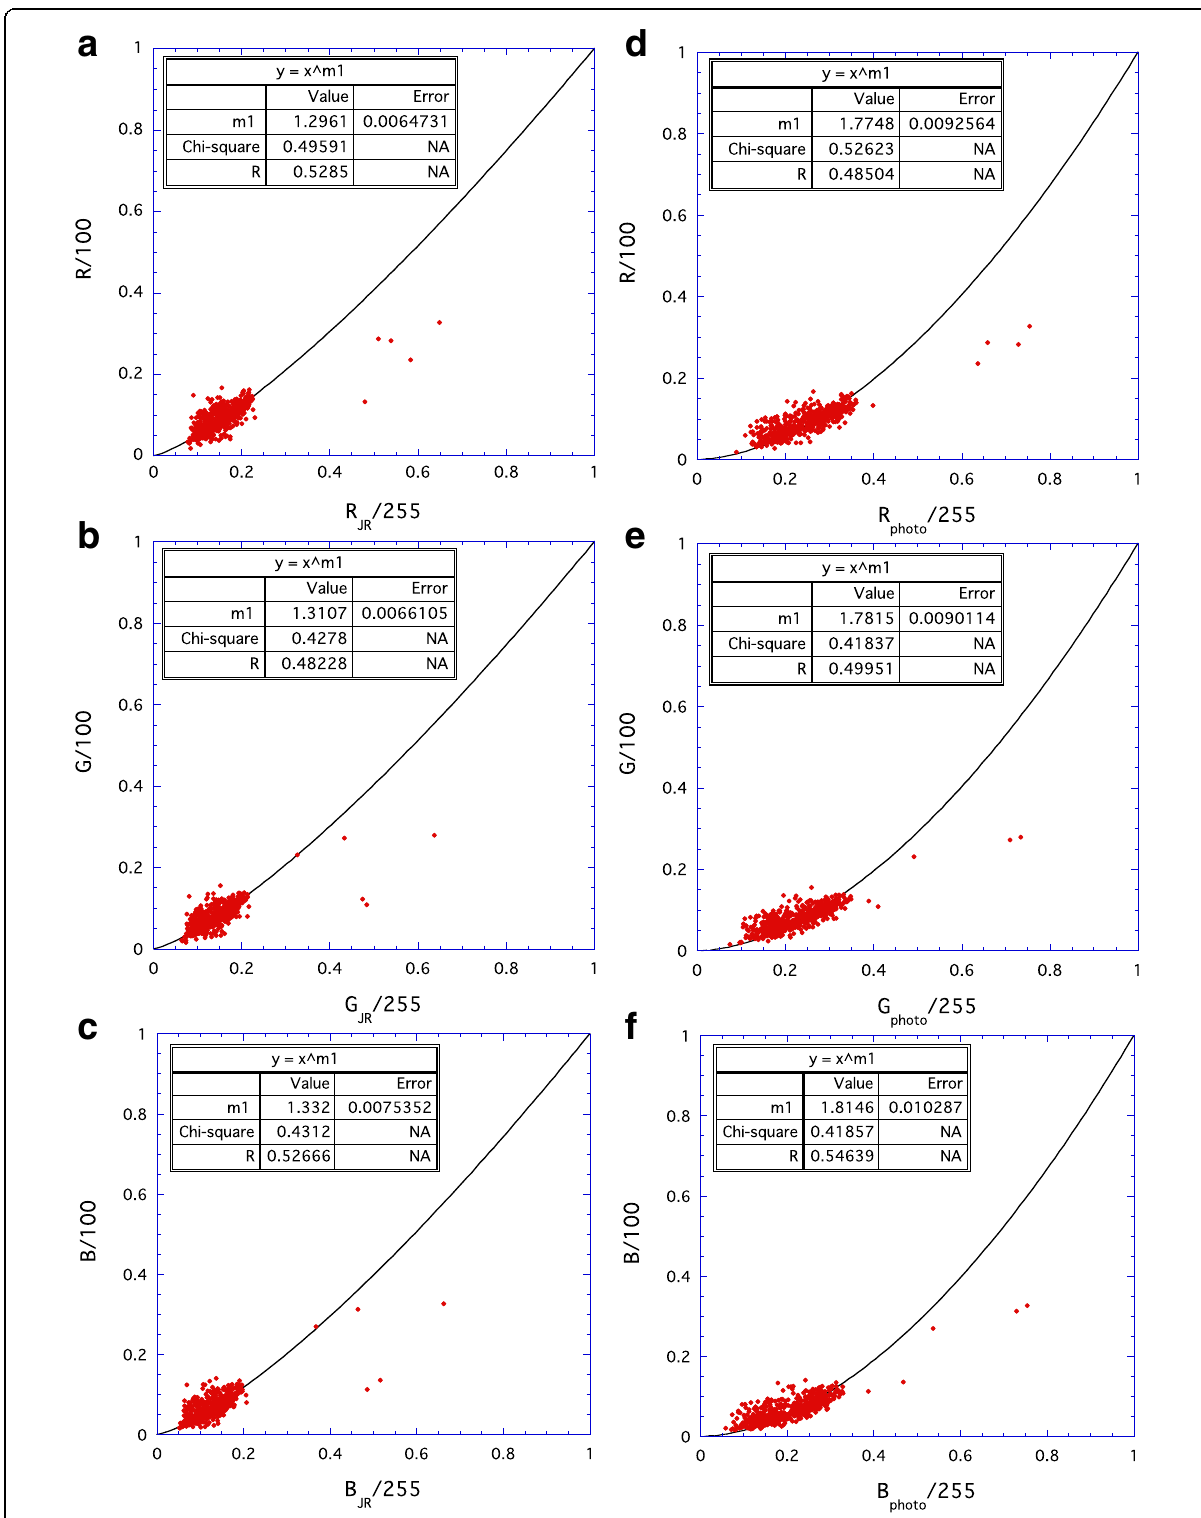
Fig. 3 Relationships between linear RGB estimated from RSC measurements and shipboard R ( a ), G ( b ), and B ( c ) or photo R ( d ), G ( e ), and B ( f